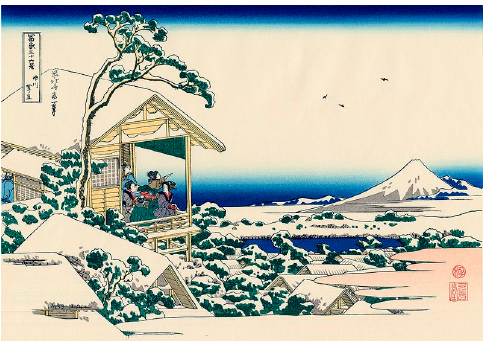
Figure 6. Katshushika Hokusai (1760–1849), Teahouse in Koishikawa the morning after a snowfall , part of the series of 36 views of Mount Fuji, https://it.wikipedia.org/wiki/Trenta_sei_vedute_del_Monte _Fuji#/media/File:Tea_house_at_Koishikawa._The_morning_after_a_snowfall.jpg, public domain.